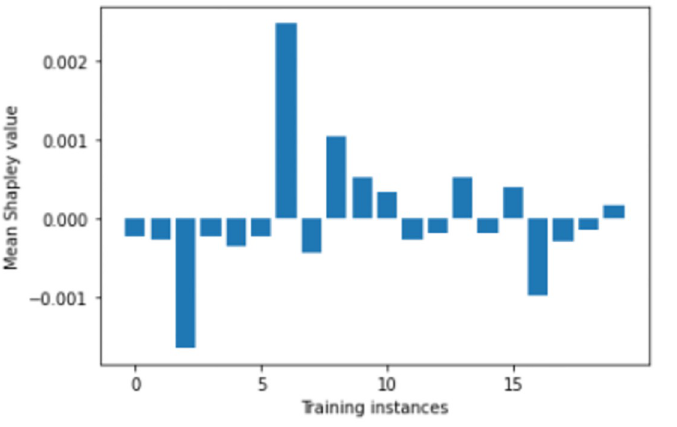
Fig 9. Estimation of input attribution for “SonyAIBOSurface1” dataset.